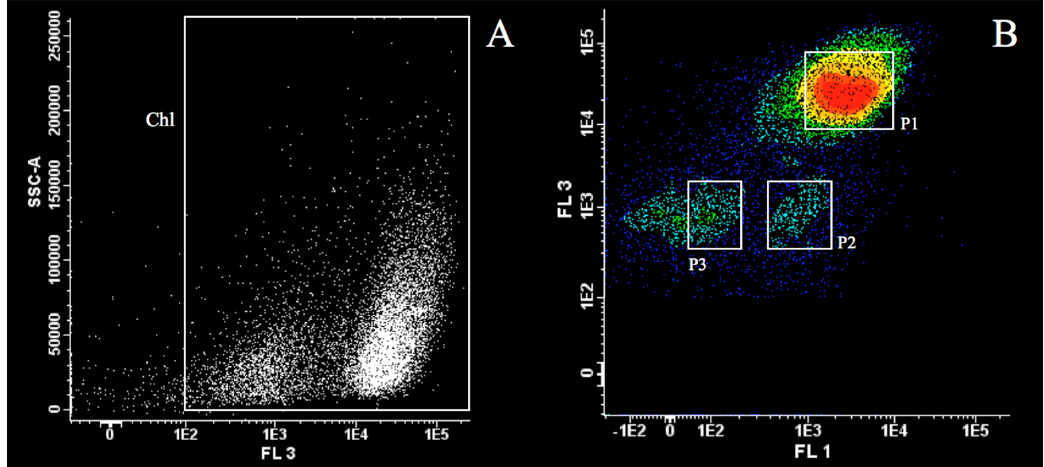
Figure 1. Gating procedure used for the isolation of microalgal strains from one of the environmental samples collected in the Red Sea by fluorescence activated cell sorting.